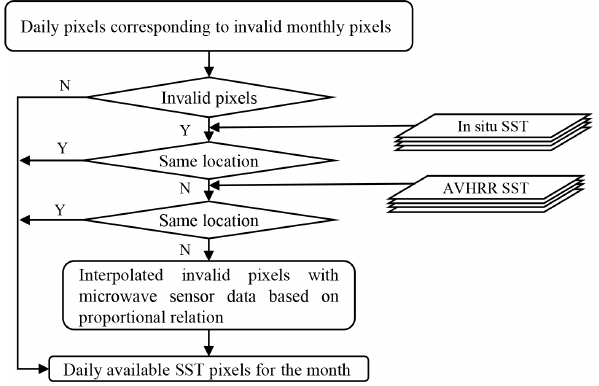
Figure 9. The summary flow chart for reconstructing invalid SST pixels in low-latitude and midlatitude inner ocean